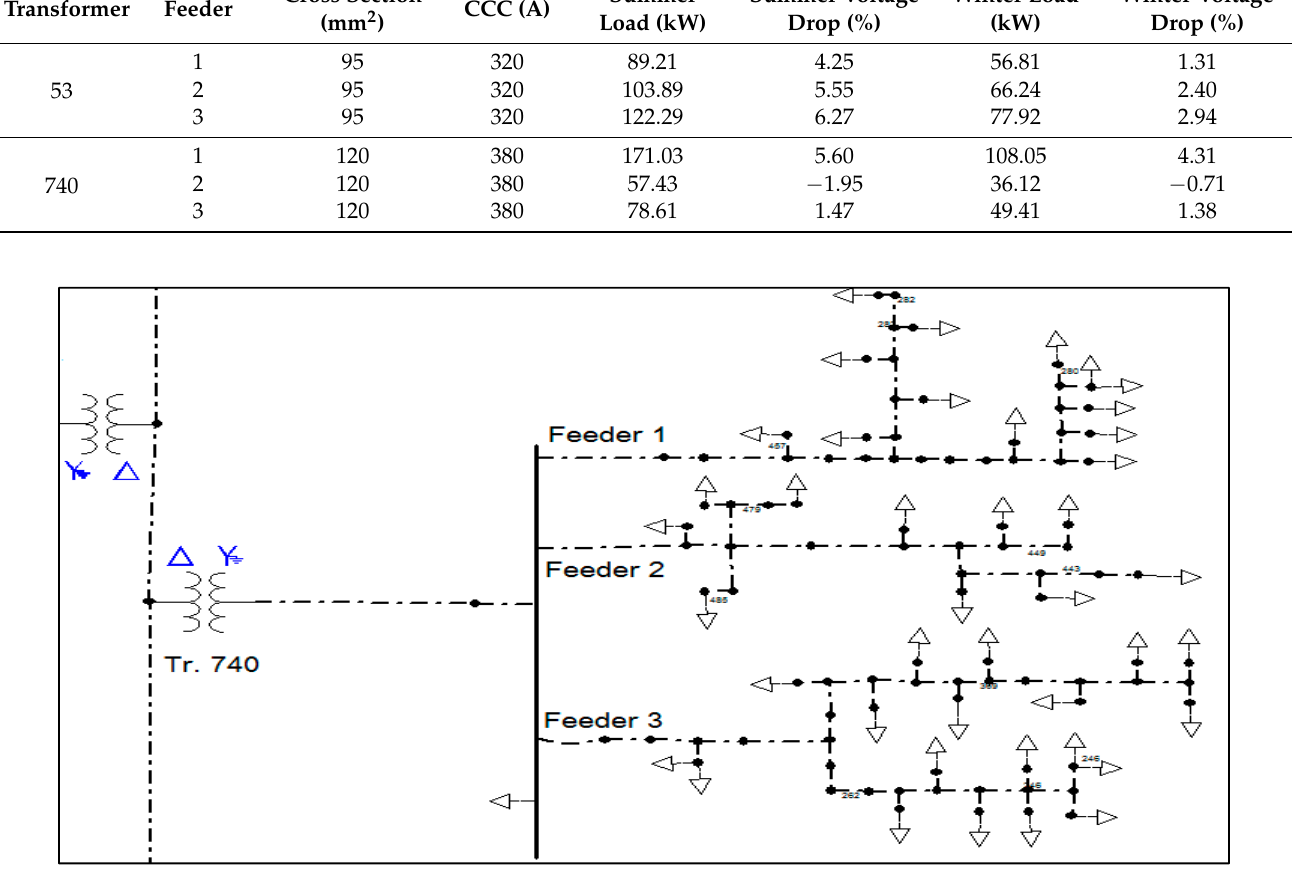
Figure 9. LV network of transformer No. 53.